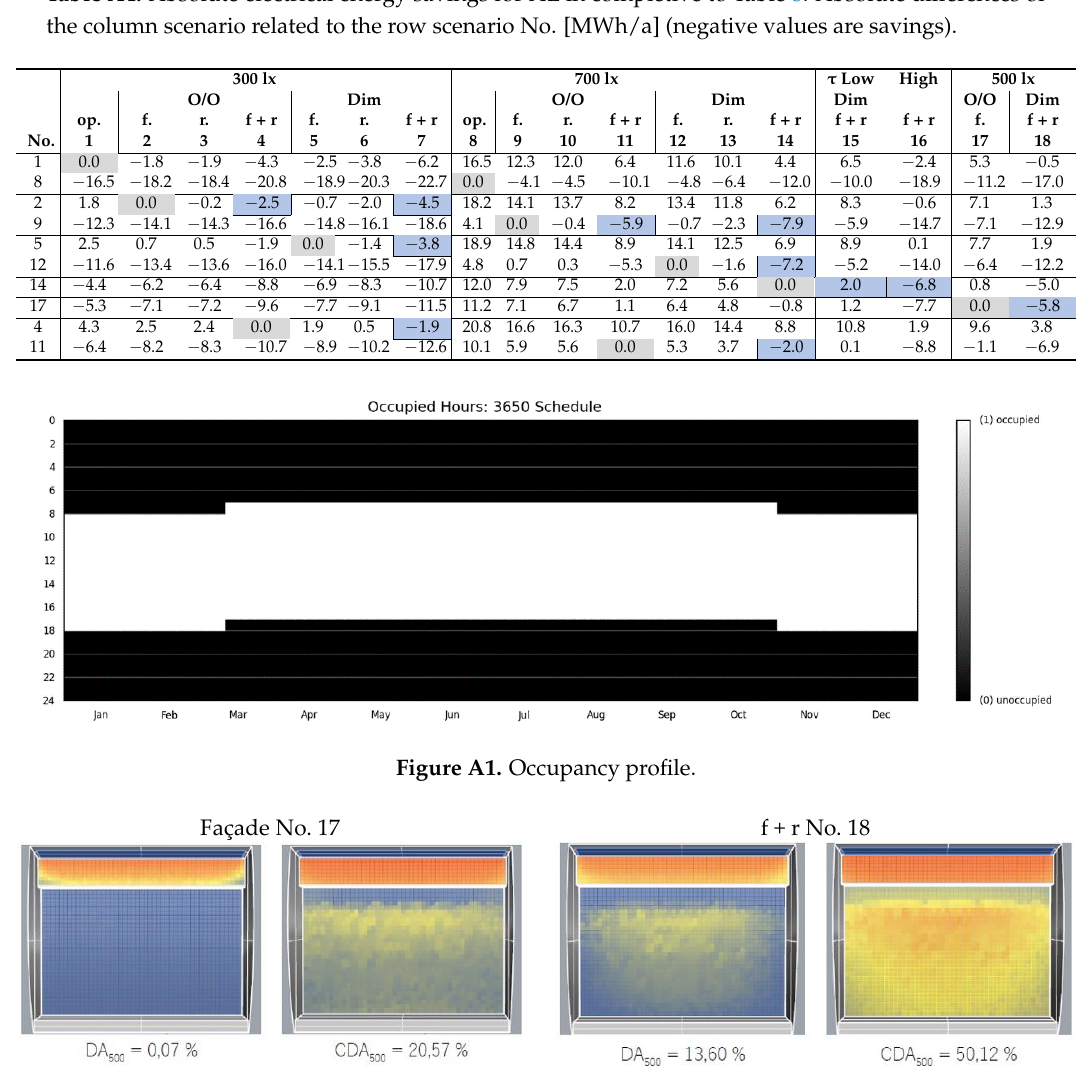
Figure A2. Spatial distribution of annual daylight indicators for scenarios with target illuminance 500 lx (Nos. 17 and 18).